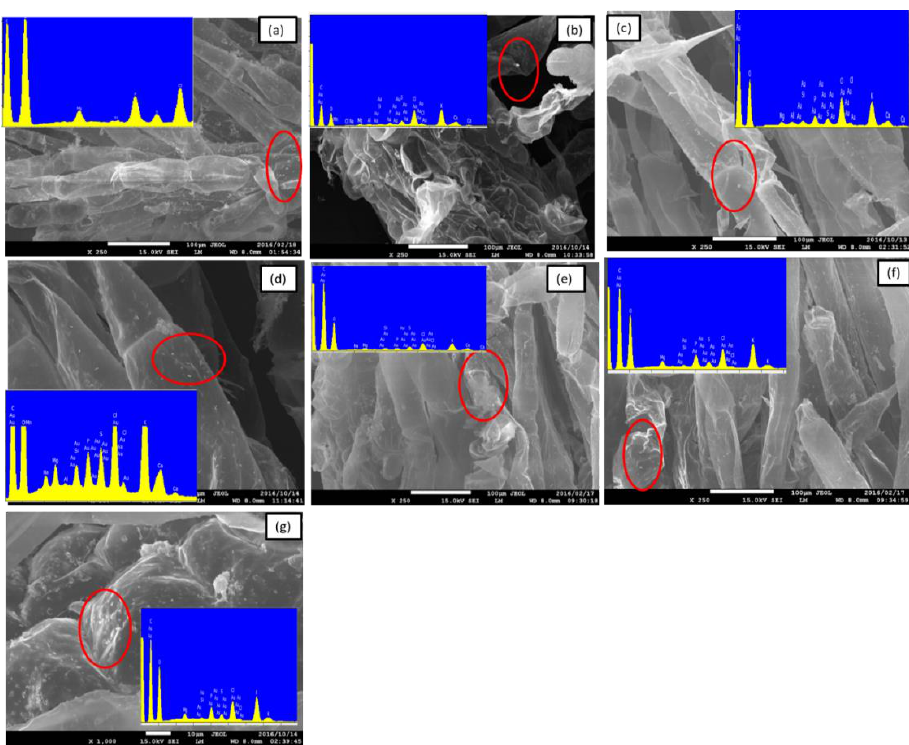
Figure 5. SEM images for nAu-treated and non-treated plant roots ( a ) control, ( b ) 5 nm-Cit, ( c ) 20 nm-Cit, ( d ) 40 nm-Cit, ( e ) 5 nm-BPEI, ( f ) 20 nm-BPEI, and ( g ) 40 nm-BPEI. Red circles indicate spots where EDX scan was taken, and the insert is the EDX spectra. Peaks indicate that gold, carbon, oxygen, magnesium, calcium, and silicon were all identified.